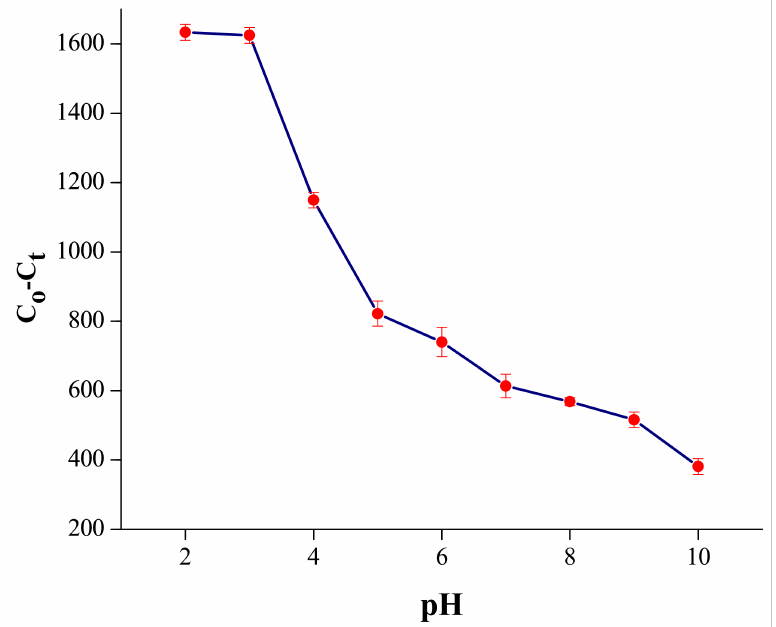
Figure 4. Effect of pH on adsorption of Cr(VI) on the MNPs/rGO/PMMA composite; adsorbent amount, 150 mg; shacking time, 30